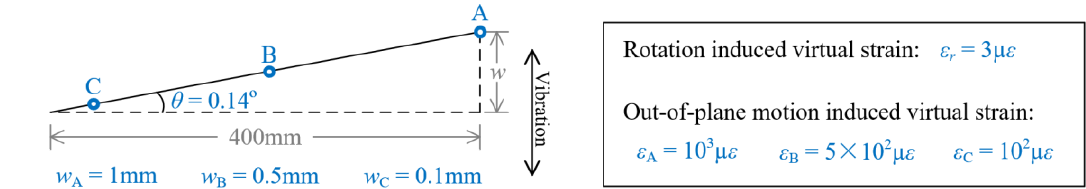
Figure 13. The schematic of assessing out-of-plane-rotation- and out-of-plane-displacement-induced virtual strains in the cantilever panel vibration experiment.